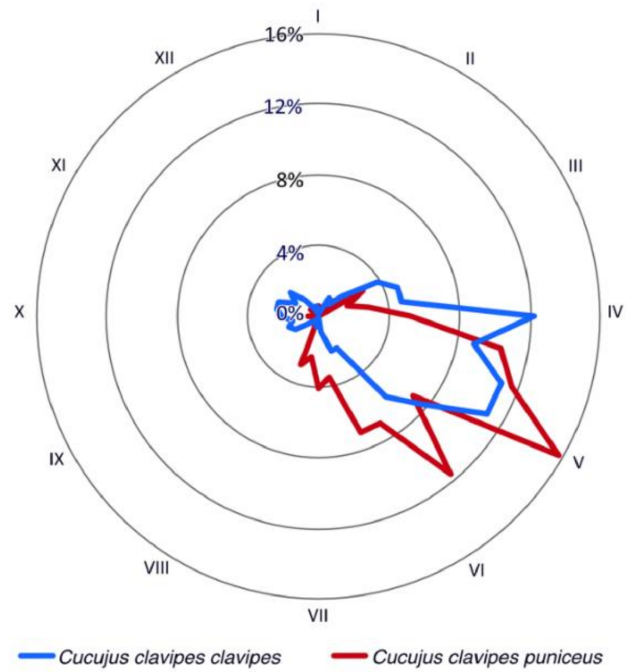
Figure 2. Phenological activity of adult Cucujus clavipes subspecies (particular months of the year are written as Roman